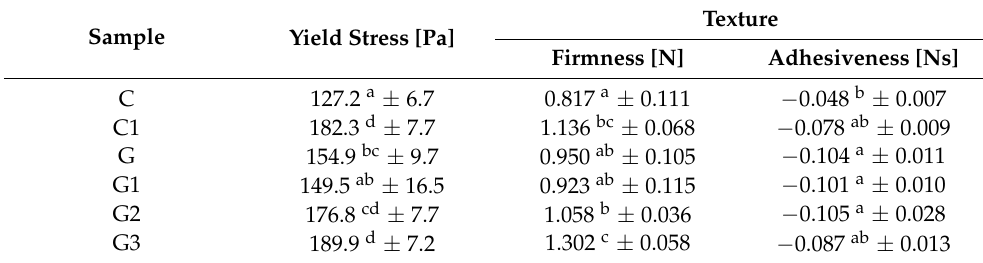
Table 1. The physical properties of yoghurts. The abbreviations in the table refer to the control sample (C), control yoghurt with 6% inulin (C1), yoghurt with green tea (G), yoghurt with green tea and 3% inulin (G1), yoghurt with green tea and 6% inulin (G2), yoghurt with green tea and 9% inulin (G3). Texture Sample Yield Stress [Pa]